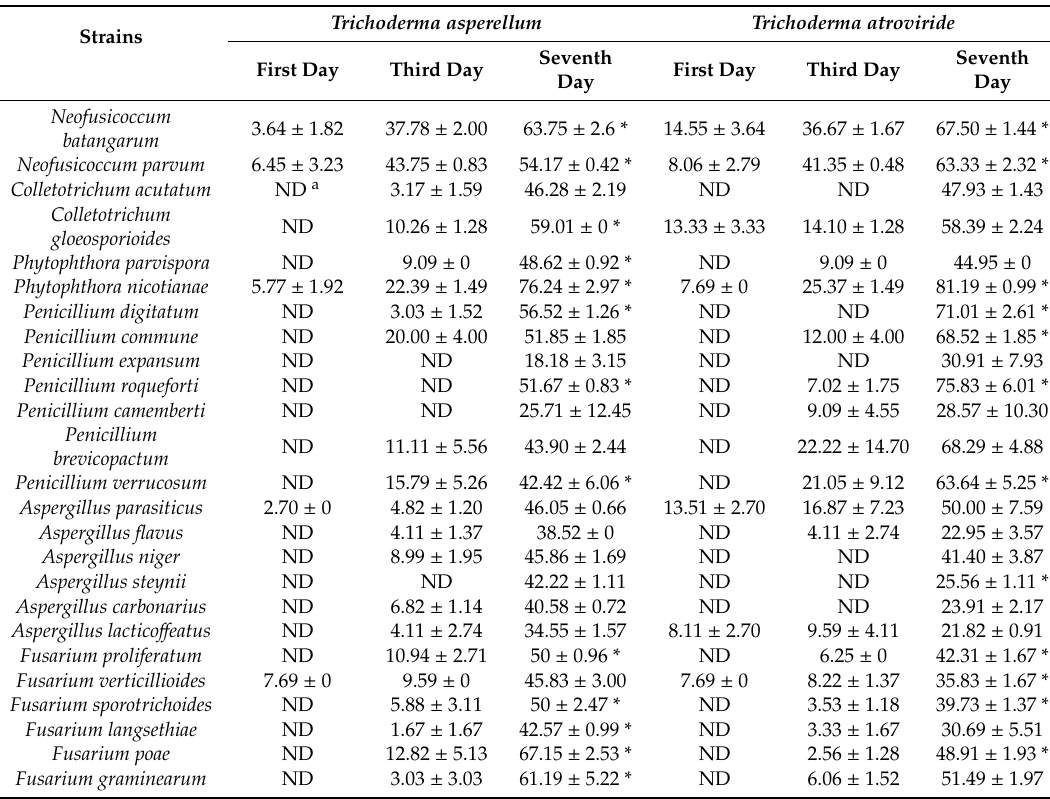
Table 3. The percentage inhibition of radial growth (PIRG) in dual culture assay. Results are expressed as the ± standard error of PIRG after 1-, 3-, and 7-day incubation; * Represents pathogens that showed signs of mycelial lysis due to mycoparasitism by Trichoderma asperellum IMI393899 and T. atroviride